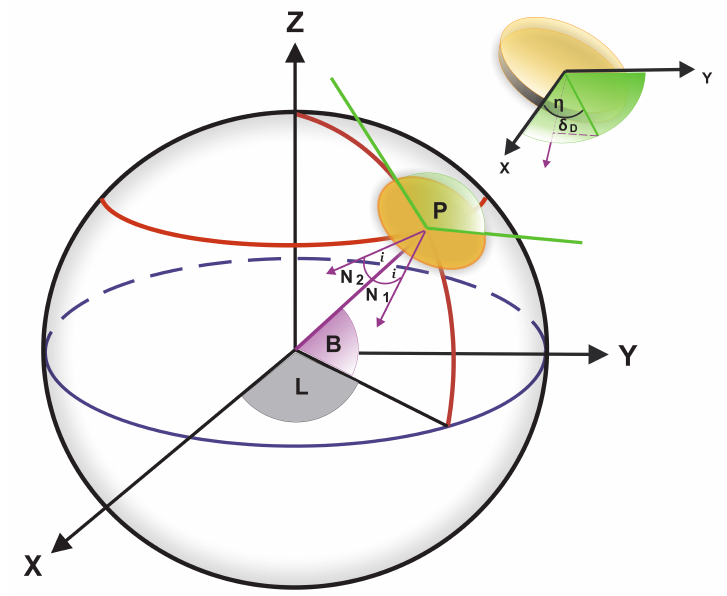
Figure 1. A schematic illustration of angles δ D (the polar angle between the normal to the galaxy plane and the main plane of the coordinate system) and η (the azimuth angle between the projection of this normal onto the main plane and the direction towards the zero initial meridian). The angle of inclination i is the angle between the normal to the plane of the galaxy observer’s line of sight, while P is the angle of the position in the frame of reference. N 1 and N 2 are possible positions of the normal to the galaxy plane-directed line segment inside the sphere. If we were also interested in the rotation direction of the galaxy, we would have two more normal vectors N 0 and N 0 different from vectors N 1 and N 2 that they would 2 1 be directed line segment outside the sphere. L and B are the longitude and latitude of the reference coordinate system (for more details see Pajowska [9], Godłowski [31], Aryal et al. [50]). Any statistical study involving orientations must take into account that directional variables are cyclic [51] and moreover in theoretical “random” distribution of analyzed angles can be not uniform. As results tests statistics could be significantly modified and must be obtained from simulations (see [9] for detailed discussion) or use the test specially dedicated to this problem like Cramer-von Mises test [52,53] and Watson test [54,55]. The value of the inclination angle can be obtained using the Holmberg formula valid for oblate spheroids [32]